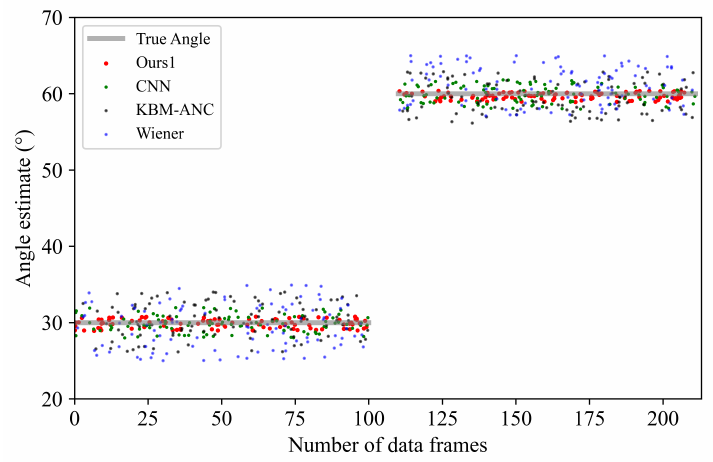
Figure 22. Statistics of angular estimates of beam formation after using the four noise-reduction methods.